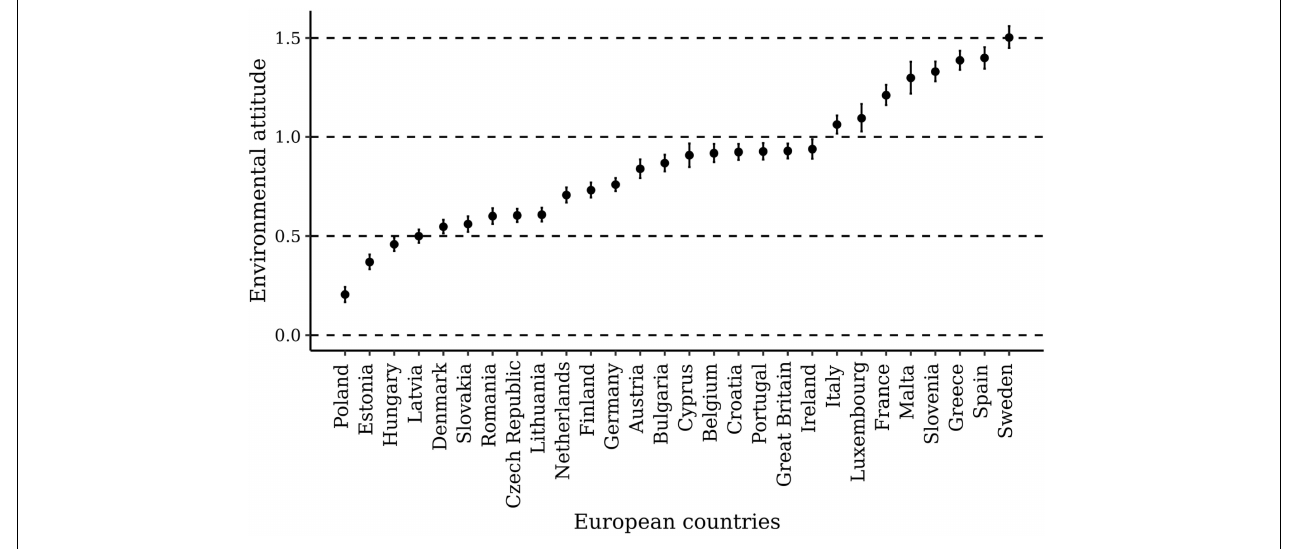
FIGURE 2 | Environmental attitude in 28 European countries. The average attitudes are presented within their 90% credible intervals.